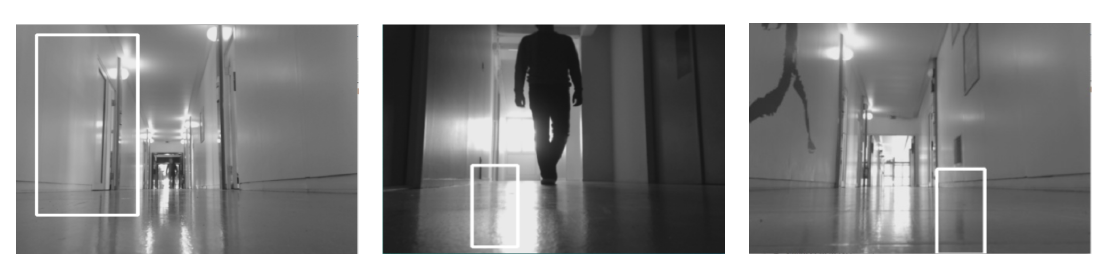
Figure 8. False positives.